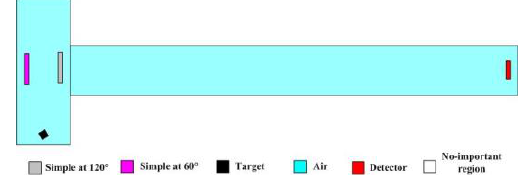
Fig.8 The C/E values integrated over the specified energy ranges at 60° （ Φ13 cm ）